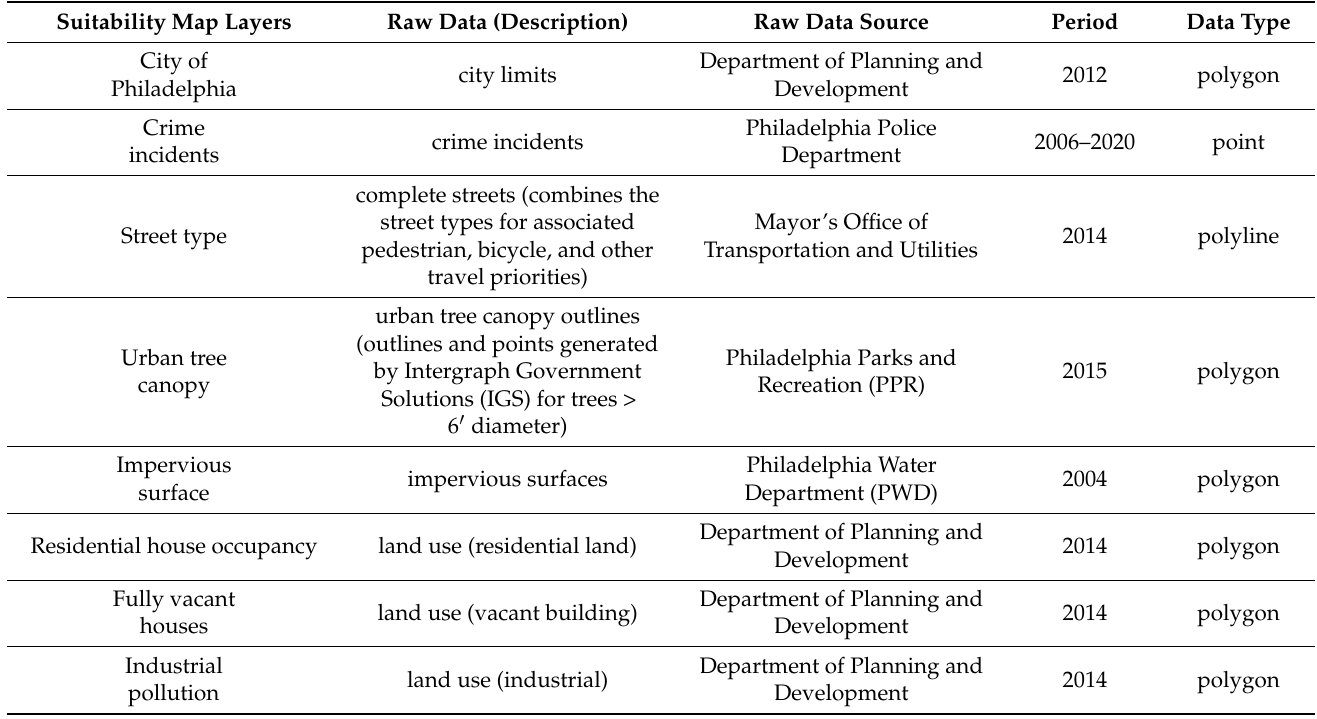
Table 1. Characteristics of GIS data